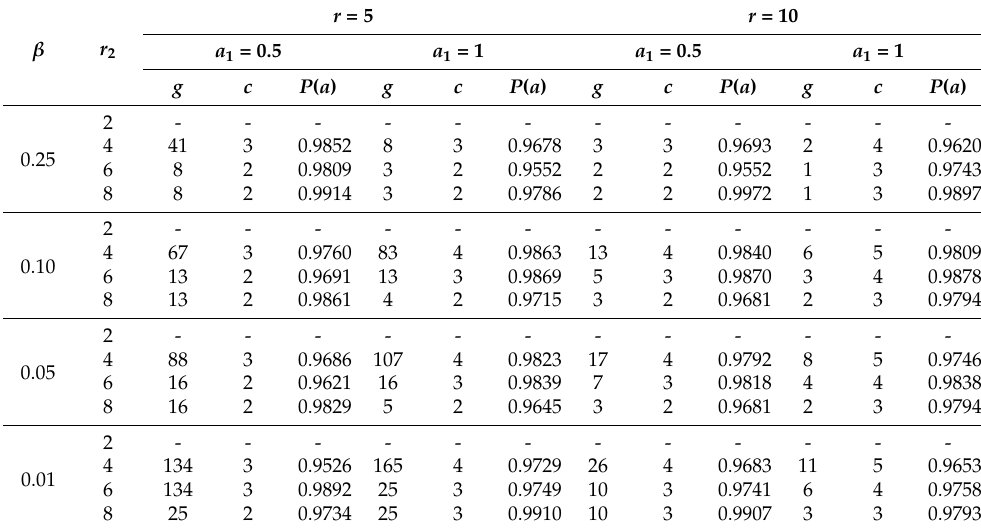
Table 1. GASP for a = 1, b = 1, and α = 1.25, showing minimum g and